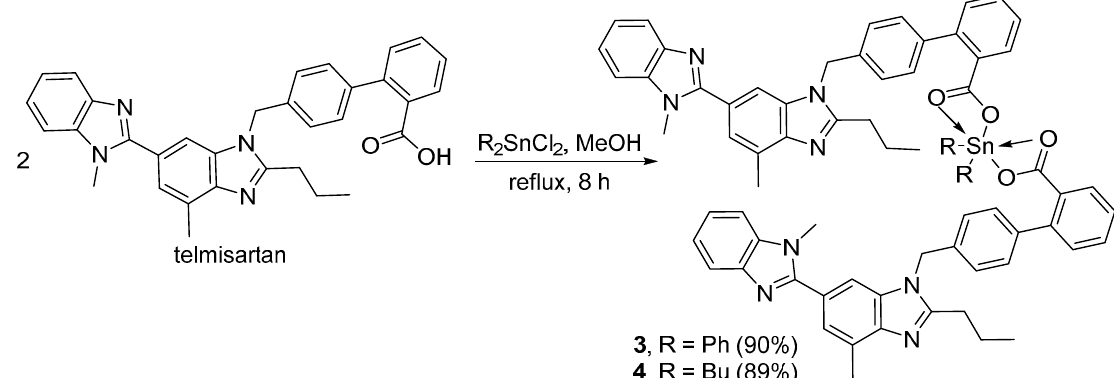
Figure 1. Synthesis of triorganotin(IV) complexes 1 and 2 .